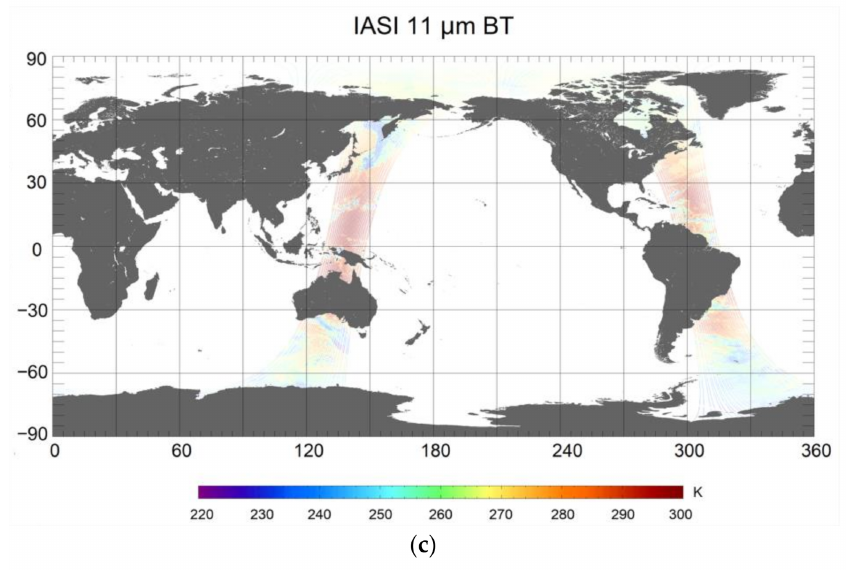
Figure 2. ( a ) The HY-1C COCTS 11 µ m BT, ( b ) the RSD of HY-1C COCTS 11 µ m radiance, and ( c ) the IASI 11 µ m BT for one orbit on 22 May